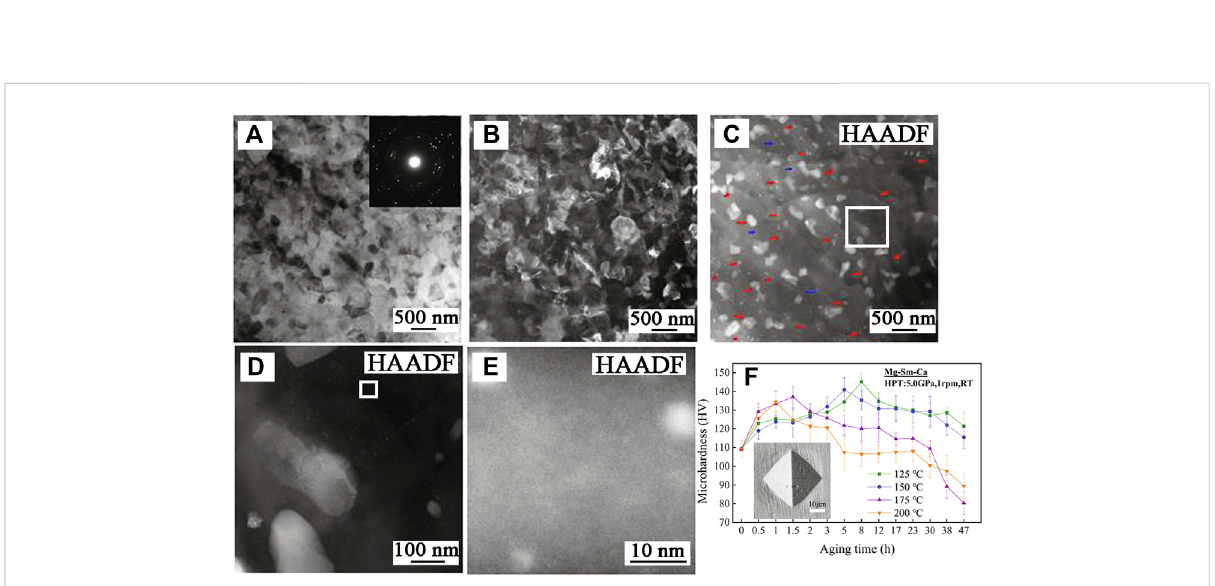
FIGURE 11 MicrostructureofMg-Sm-CaalloysprocessedbyHPTandagingtreatmentat125 ° Cfor8 h: (A) TEMbright- fi eldmicrograph; (B) TEMdark- fi eld micrograph; (C) HAADF-STEM micrograph; (D) high magni fi cation HAADF-STEM micrograph of white spot in (C) ; (E) high magni fi cation HAADF- STEM micrograph of white spot in (D) ; (F) microhardness of different aging conditions (Liu et al.,